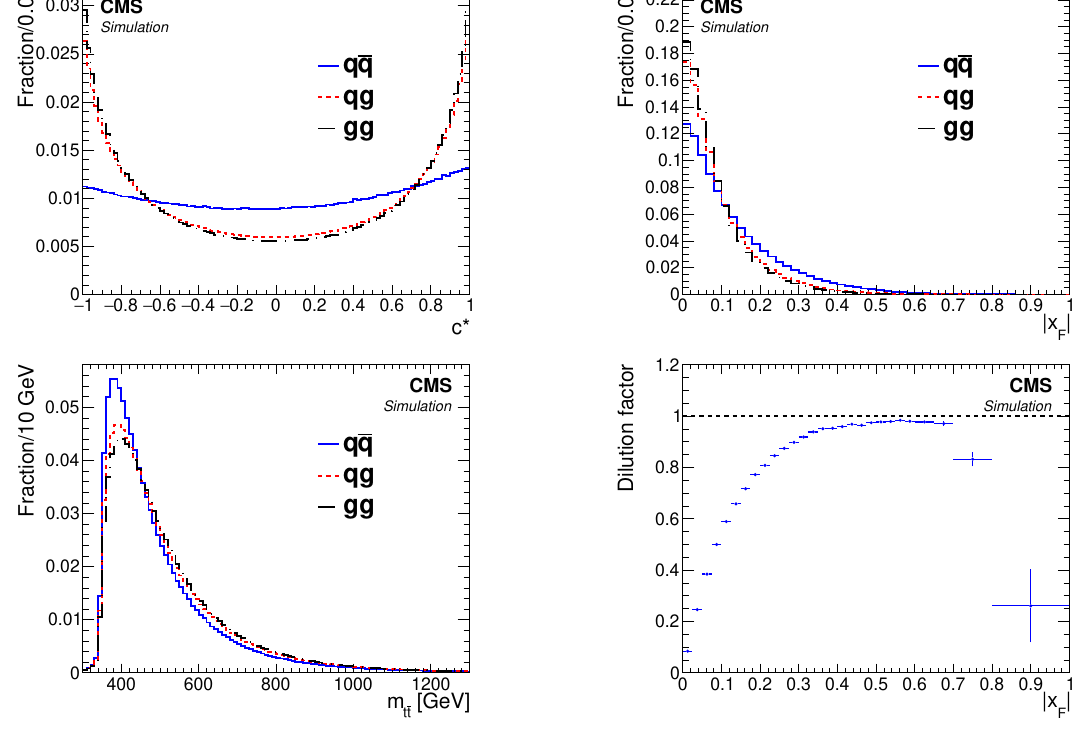
j (upper right), and m (lower left) distributions F tt j F